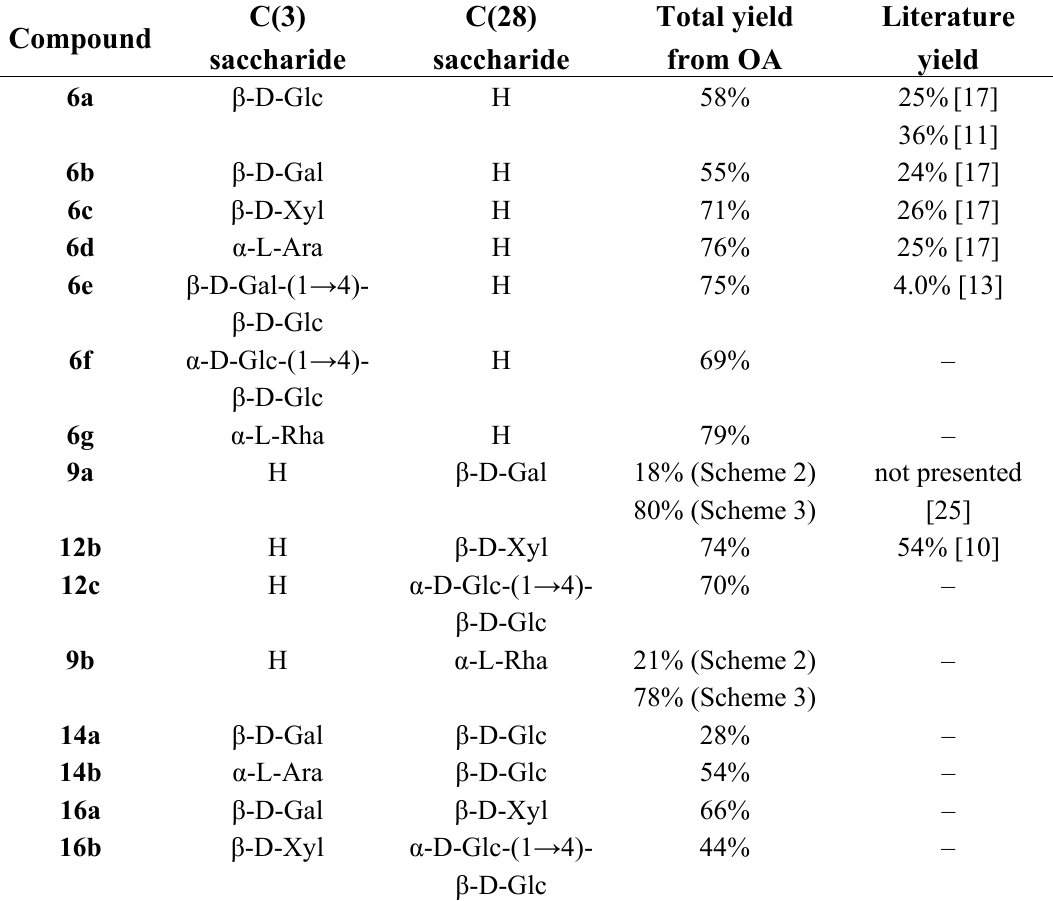
Table 1. OA glycosides and overall yields from